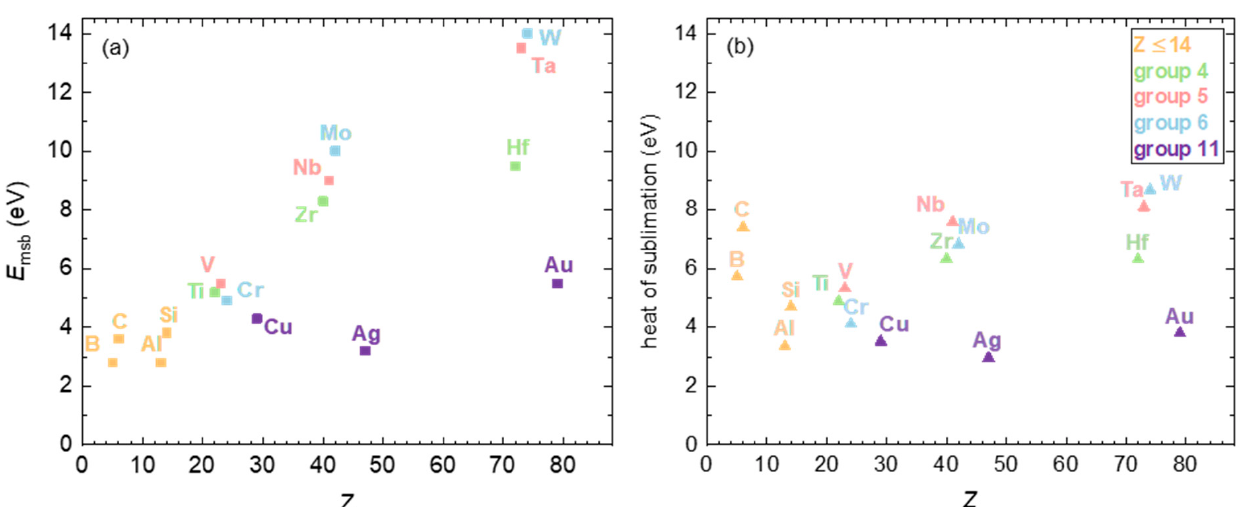
Figure 10. ( a ) The modified surface binding energy in dependence of the atomic number used in our SRIM simulations. ( b ) The heat of sublimation, which is used in SRIM as the default value for SBE, in dependence of the atomic number. a smaller SBE). Figure 11a shows the sputtering yields that were calculated using SRIM for different target materials in dependence of the modified surface binding energies.